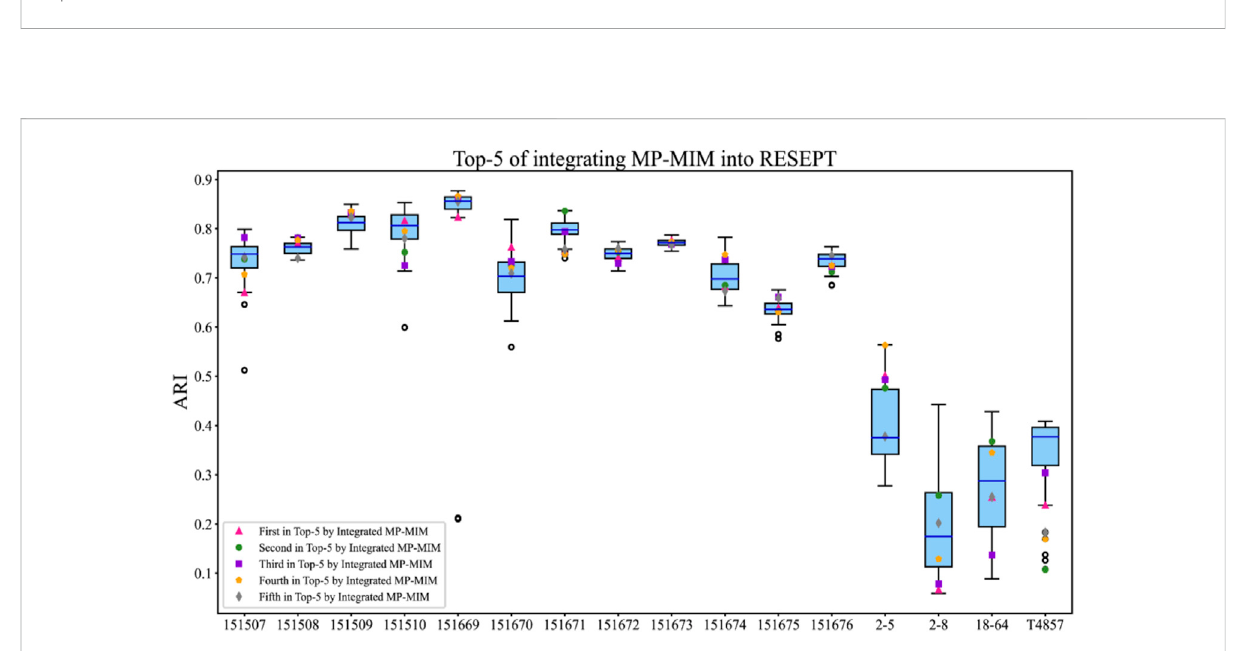
FIGURE 7 Top 5 tissue architecture identi fi cations of integrating MP-MIM into RESEPT. The blue horizontal line indicates the median ARI of all values, and this median value is set as the baseline on each sample in this study. The top 5 ARI values are marked in different colors and